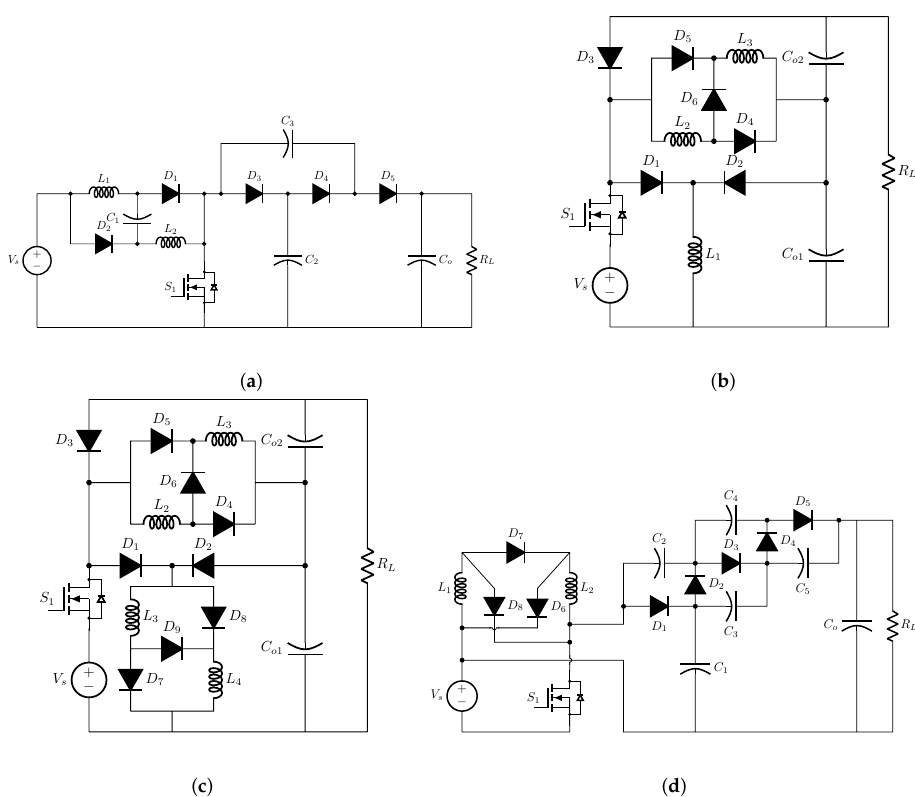
Figure 15. Switched Inductor (SL) Techniques. ( a ) Boost Converter based on SC and SL, ( b ) XY Converter (L-SL), ( c ) XY Converter (SL-SL) and ( d ) N-level boost Converter with SL and VM. Table 8 summarises more details about the step-up converter based on switched inductor (SL) technique in terms of component number, voltage gain, voltage stress on the main switch, voltage stress of output diode, input and output voltage, switching frequency and power rating, duty cycle, efficiency, the feature of each DC/DC converter and applications. Despite its features (high boost ability and being amenable in many converters), SL needs more passive components. This kind of converter is not preferable for high power applications. The SL technique can be used in mid-range DC/DC converters and high gain DC/DC